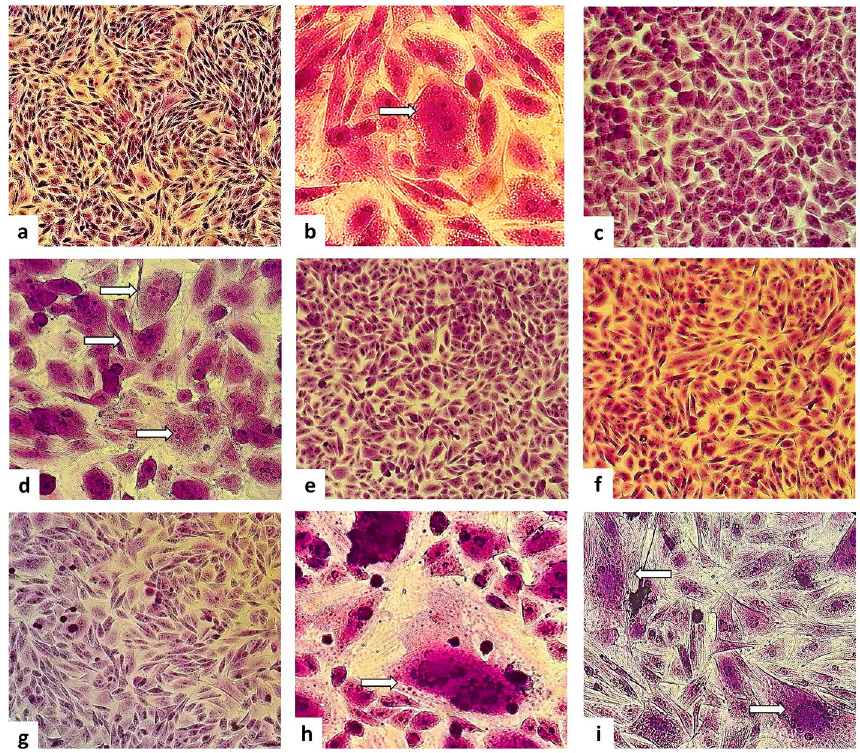
Figure 4. Co-culture with ovine third eyelid cells (OTE) and somatic cells from milk infected with CAEV CO (SCM+) treated with Azadirachta indica and Melia azedarach leaf extracts for 90 min after 63 days of culture. ( a ) Negative culture control with OTE cells (×100 magnification). ( b ) Co-culture of OTE and SCM+ cells submitted to CEE-AI treatment , with syncytia (arrows) (×200 magnification). ( c ) Co-culture of OTE and SCM+ cells subjected to EAF-AI treatment (×100 magnification). ( d ) Co-culture of OTE and SCM + cells subjected to MF-AI treatment, with syncytia (arrows) (×100 magnification). ( e ) Co-culture of OTE and SCM+ cells submitted to CEE-MA treatment (×100 magnification). ( f ) Co-culture of OTE and SCM+ cells subjected to EAF-MA treatment (×100 magnification). ( g ) Co-culture of OTE and SCM+ cells subjected to MF-MA treatment (×100 magnification). ( h ) Co-culture of OTE and SCM+ with syncytia (arrows) (control treatment without extract) (×200 magnification). ( i ) Positive control of CAEVCO-infected OTE cells